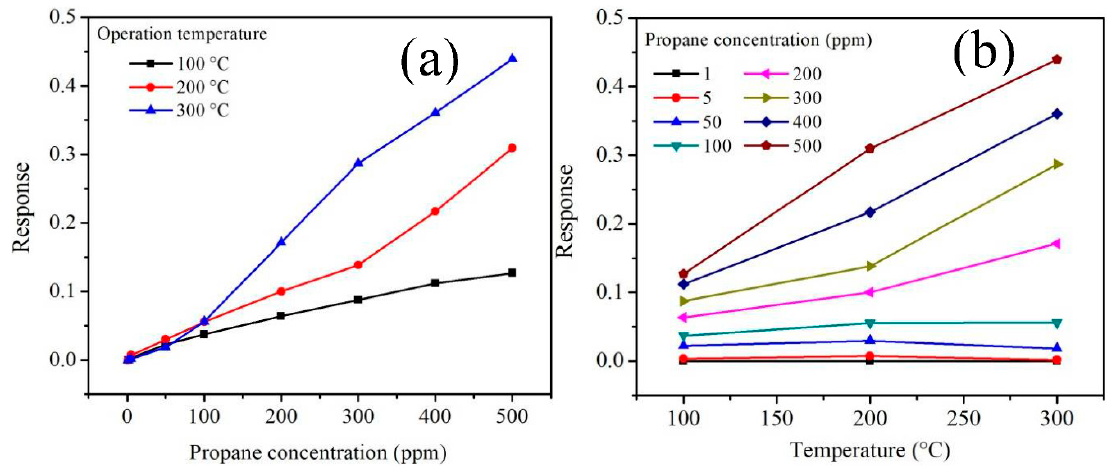
Figure 12. Response of the manganese antimonate nanoparticles as a function of ( a ) propane concentration and ( b ) operating temperature.